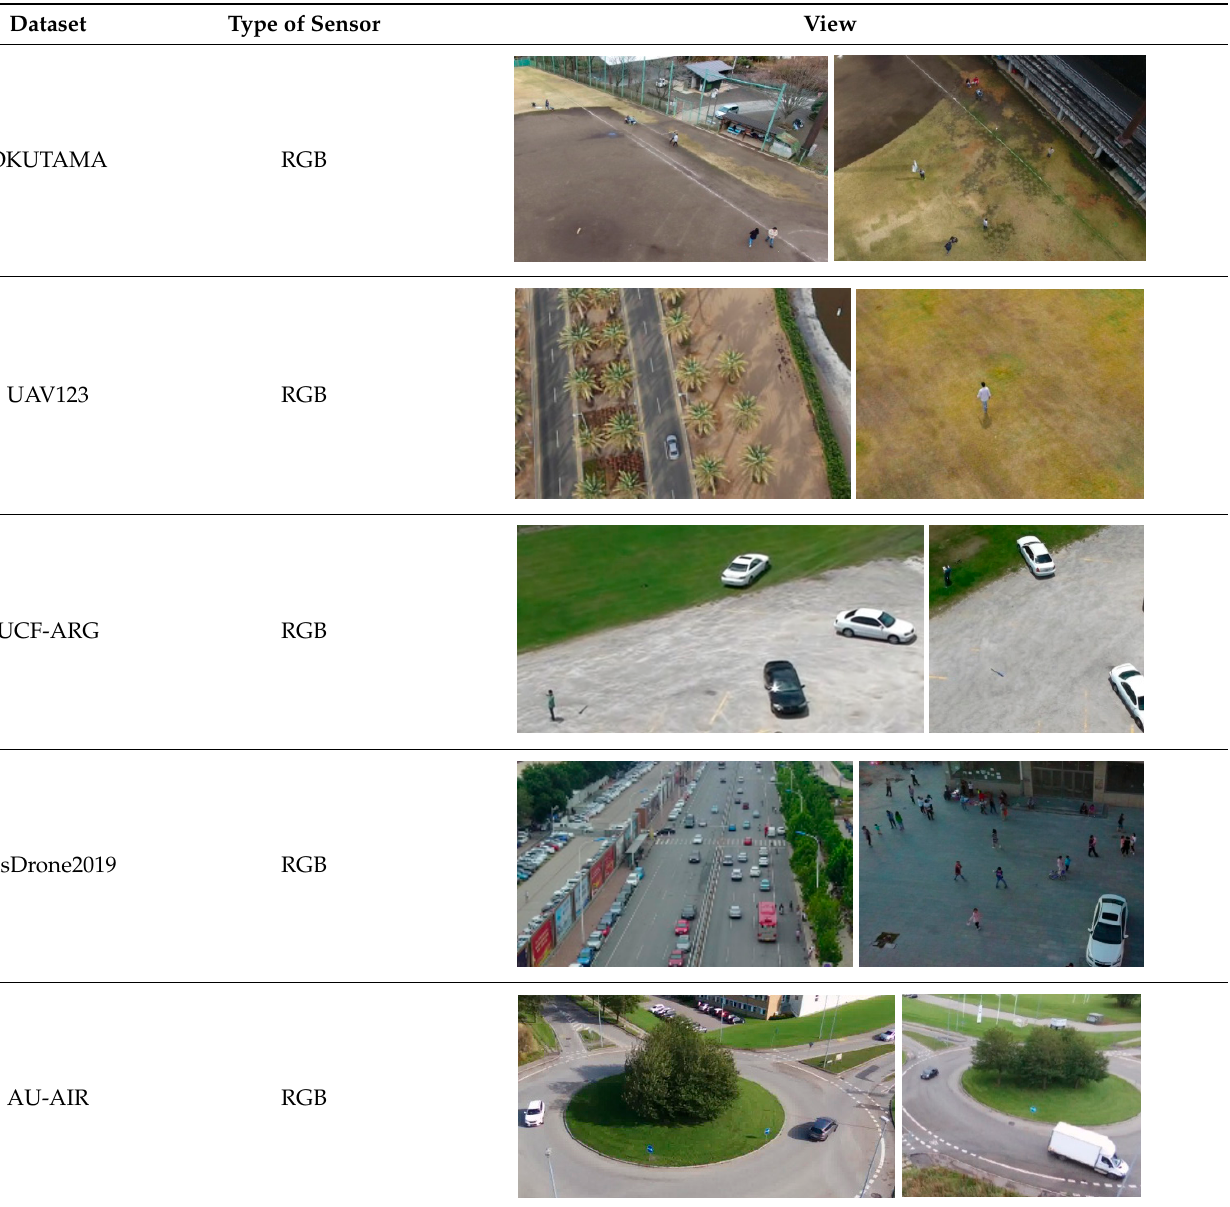
Table 1. Views from each free available video datasets.